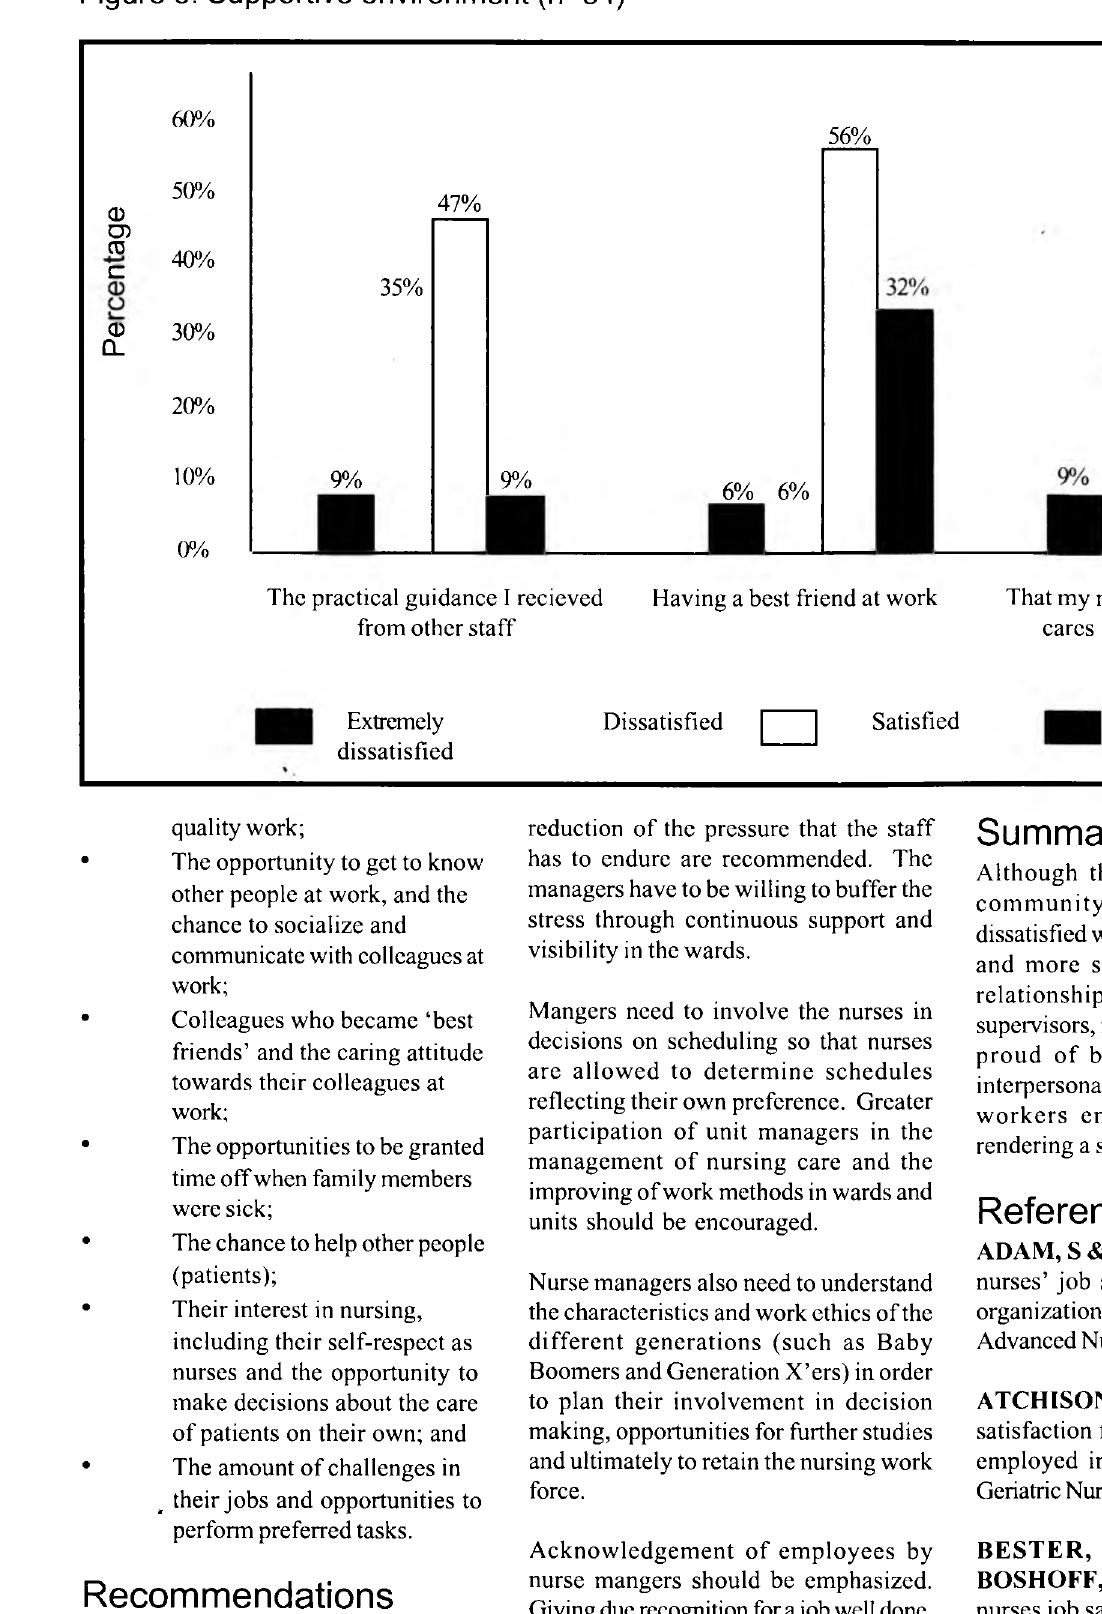
Figure 8: Supportive environment